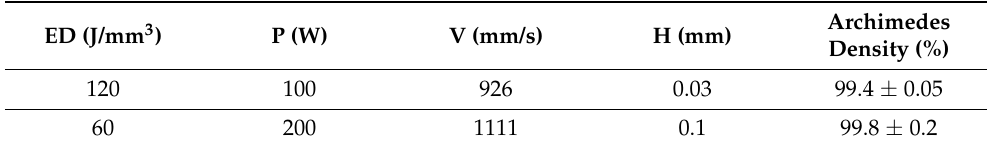
Table 2. Printing parameters together with the resulting density of samples chosen for further evaluation ( n = 5).